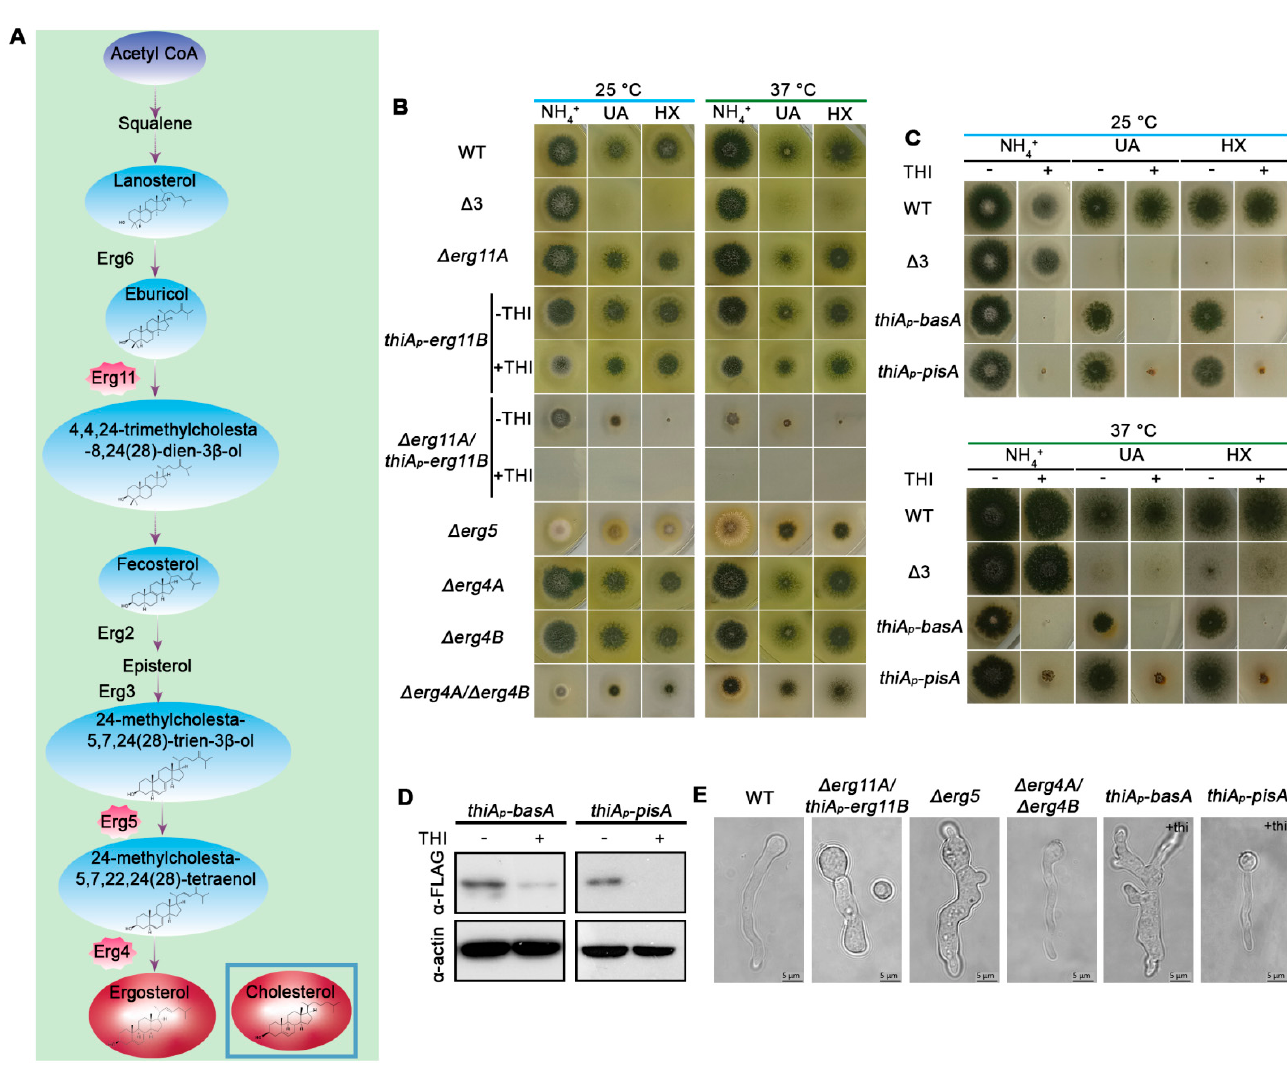
Figure 1. Effect of reduction of biosynthesis of phosphatidylinositol (PI), sphingolipids or ergosterol in A. nidulans growth. ( A ) Pathway of ergosterol biosynthesis in Aspergilli (adapted from [55,56]). Only proteins related to the present work are highlighted. Chemical formulas of ergosterol precursors, ergosterol and cholesterol are shown for comparison. ( B ) Growth tests of ergosterol biosynthesis mutants relative to isogenic controls. WT is a standard wild-type A. nidulans strain. Δ 3 is a stain with total genetic deletions in the three major purine transporters UapA, AzgA and UapC (see Table S1). Growth is on MM supplemented with 1% glucose as C source and different nitrogen sources, such as 10 mM ammonium tartrate (NH 4+ ), 0.5 mM uric acid (UA) or 0.5 mM hypoxanthine (HX). Thiamine presence or absence from the growth medium is depicted as +thi or –thi, respectively. ( C ) Growth tests of sphingolipid or PI biosynthesis knockdown mutants relative to isogenic controls. Details are as in ( B ). ( D ) Western blot analysis, using anti-FLAG antibodies, confirming the repression of FLAG-tagged BasA or PisA, upon thiamine addition in the growth medium. Equal loading and protein steady state levels are normalized against the amount of actin, detected with a specific antibody. ( E ) Microscopic morphology of germlings in PI, sphingolipids or ergosterol biosynthesis mutants.